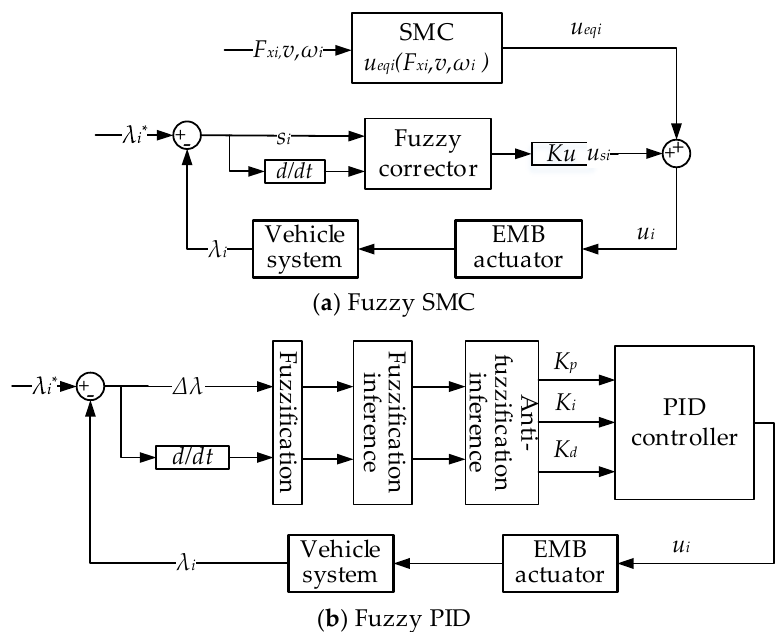
Figure 12. Diagram of fuzzy sliding mode controller (SMC) and fuzzy proportional integral and differential ( PID). di ff erential